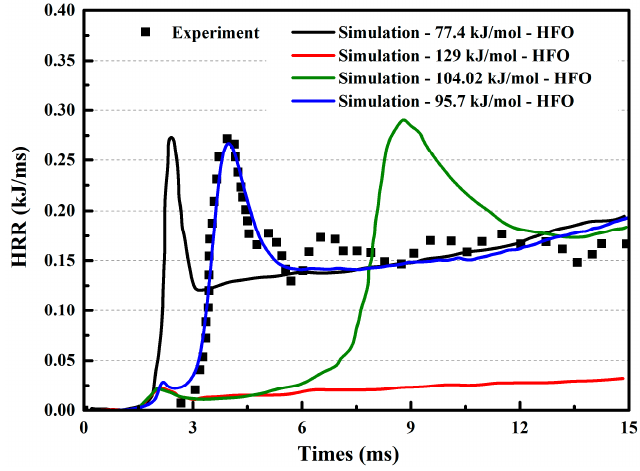
Figure 9. Heat release rate of HFO at different activation energies.